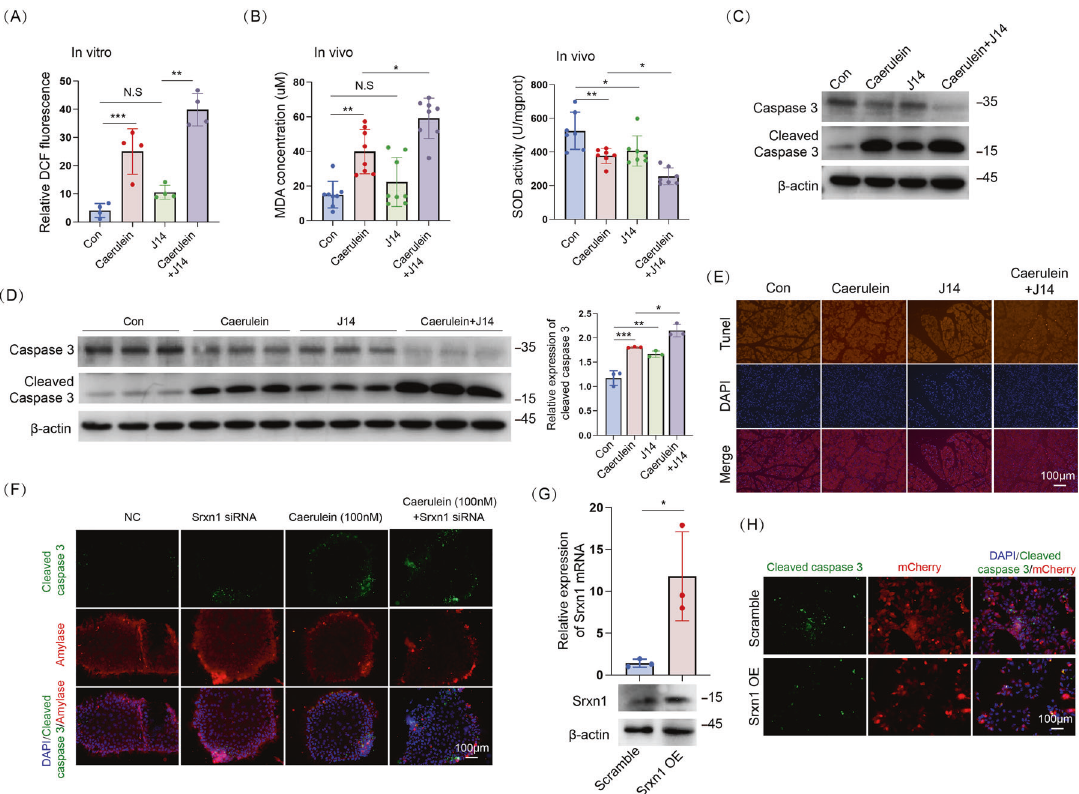
Fig. 3 SRXN1 attenuates AP by inducing oxidative stress and apoptosis. A J14 (5 μ M) signi fi cantly increased the DCF signal induced by cerulein (100 nM) in isolated acini. B J14 increased the MDA concentration and decreased SOD activity upon cerulein treatment in mice. C The cleaved caspase 3 level was substantially induced by cerulein (100 nM), and cotreatment with J14 further augmented it in acinar cells. D , E The cleaved caspase 3 was induced by cerulein at a dose of 50 µg/kg body weight eight times, and injection of J14 further promoted it in mice; TUNEL assay showed the same trend. F Acinar cells were isolated and cultured for 3 days, and Srxn1 siRNA was transfected for another 3 days and then cerulein (100 nM) was added. Amylase served as an indicator of acinar cells. G , H Lentivirus vector (mCherry) was transfected to overexpress Srxn1; IF staining of cleaved caspase 3 showed that Srxn1 overexpression prevented apoptosis induced by cerulein in acini. N. S no signi fi cance; Con control; NC negative control; OE overexpression; * p < 0.05, ** p < 0.01, *** p < 0.001. Data represent three or more experiments for in vitro assays and eight for in vivo